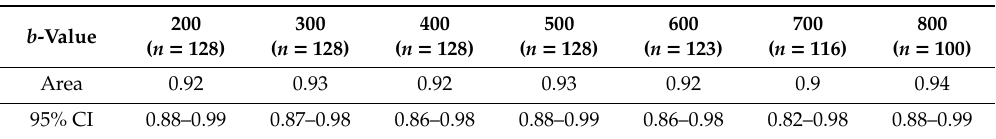
Table 2. Area under the curve ROC with each b-value in using quantitative ADC for distinguishing benign and malignant thyroid tumors.